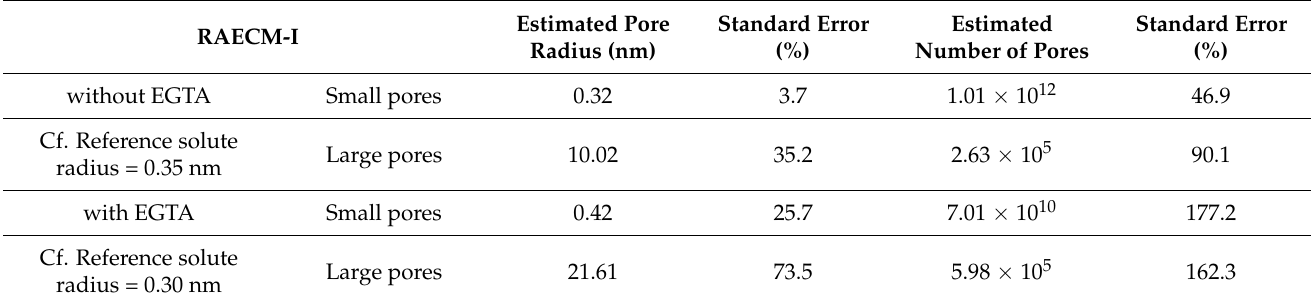
Table A3. Number and radius of small and large equivalent pore populations based on maximum likelihood optimization approach using the mean of P app for each solute in the absence and presence of EGTA. Equivalent pore number is per nominal surface area (1 cm 2 ) of RAECM-I. Standard errors are much larger than those obtained using all entries of P app .